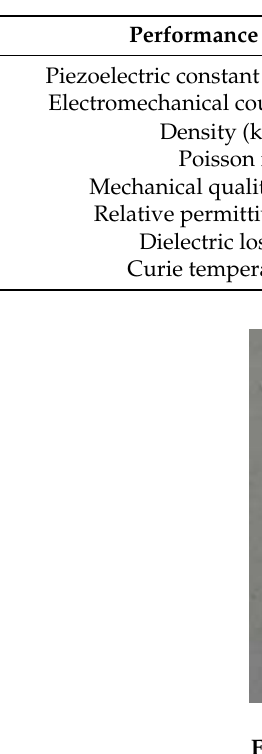
Table 1. Related performance parameters of PZT-5H.